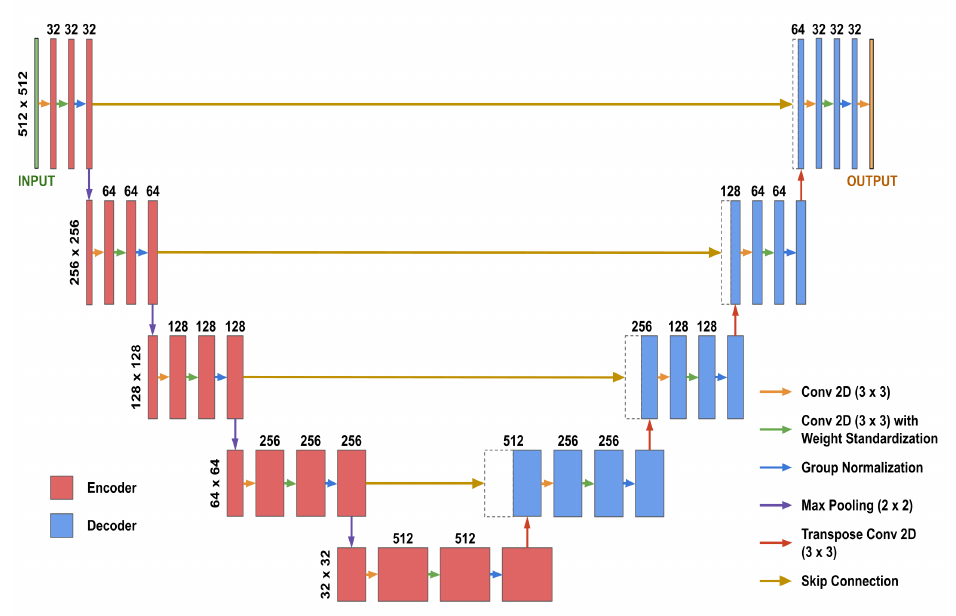
Figure 2. The U-Net architecture used for both inpainting and segmentation, which includes lay- ers grouped into three categories: the “encoder” (in red), the “decoder” (in blue), and the “post- processing” layer (the final convolutional layer). Each dotted rectangular box represents a feature map from the encoder that was concatenated to the first feature map in the decoder at the same level. We used L2 norm loss for inpainting and Dice loss, aggregated over mini-batches